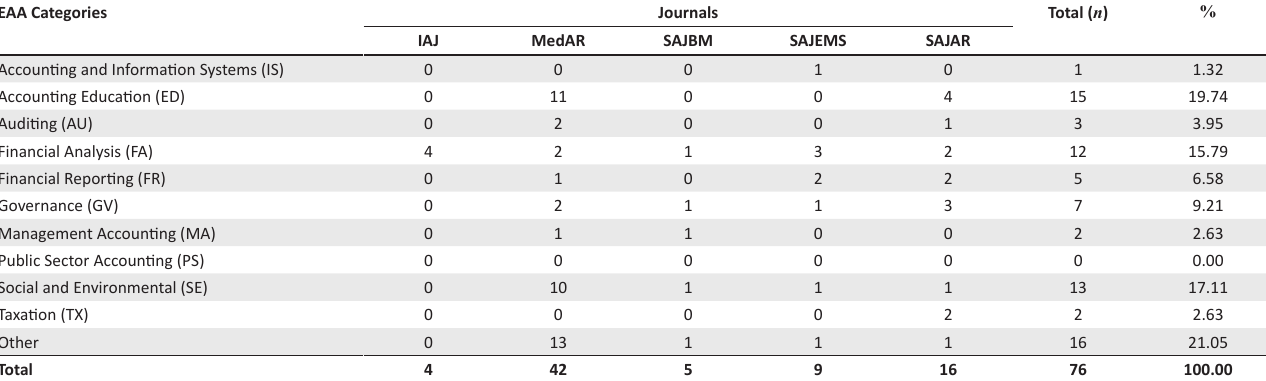
TABLE 5: Articles by EAA categories: 2015–2016